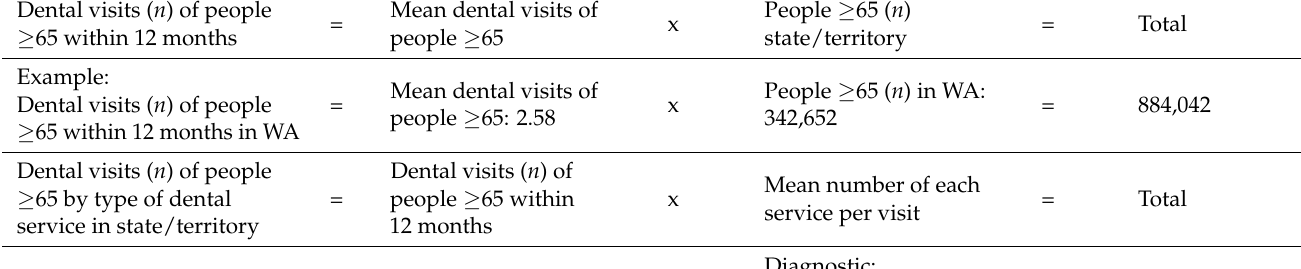
Table 1. The calculation method to obtain dental visits number ( n ) of people ≥ 65 by type of dental service in state/territory. Dental visits ( n ) of